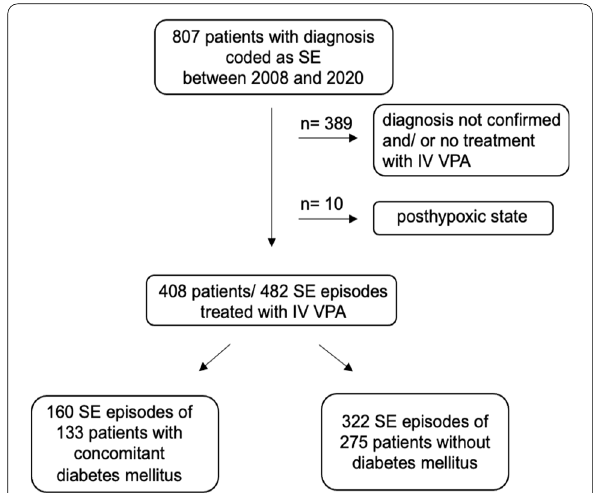
Fig. 1 Flow chart of the study cohort. Abbreviations: SE, status epilepticus; IV, intravenous; VPA, valproic